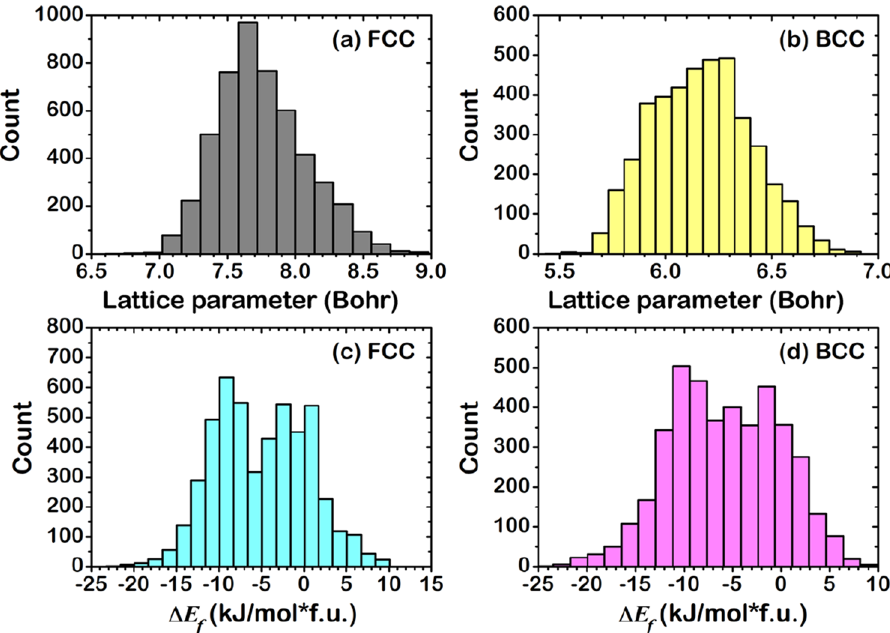
Figure 7. Distribution of ML-predicted results for ( a ) a (FCC), ( b ) a (BCC), ( c ) (cid:31) E f (FCC), and ( d ) (cid:31) E f